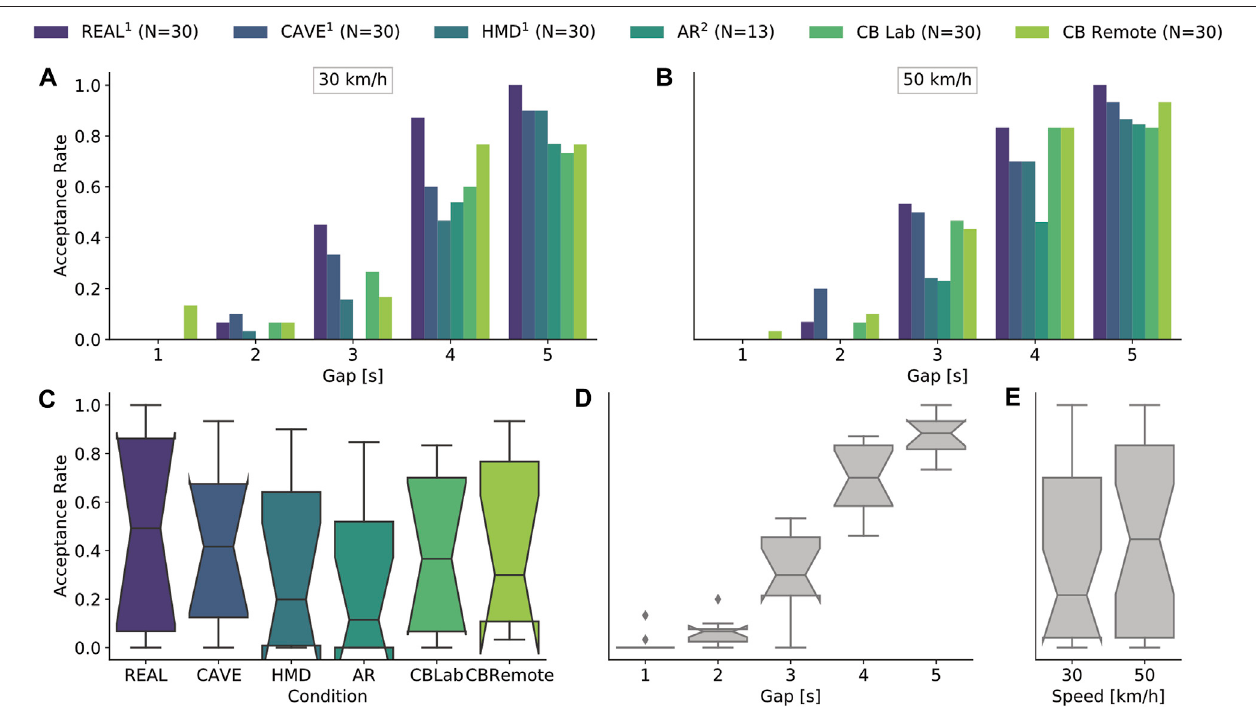
FIGURE 4 | Descriptive data of gap acceptance rates. (A,B) show the acceptance rates as a combination of vehicle gap and test environment subdivided for both levels of speed. The bottom three plots each represent one independent variable in isolation. The acceptance rates are shown as a function of (C) the experimental environment, (D) the gap sizes and (E) the levels of speed. The box plots show the distributions based on the other two respective factors. For example, (D) shows that therearecombinationsoftestenvironmentandspeedthatleadtoagapacceptanceof0 at3 s .In (A) itcanbeseenthattheseareARat30 km / h .Theexperimental data in REAL, CAVE and HMD were collected in Schneider et al. (2021). The experimental data in AR were collected in Maruhn et al. (2020).